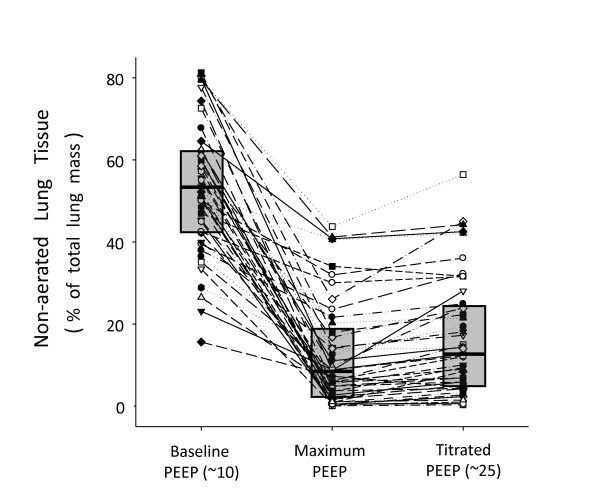
Amount of non-aerated tissue observed along the protocol. Numbers represent the percentage of non-aerated tissue (in relation to the total lung tissue) within the thick lung section (7 to 8 cm thick) from the carina to the diaphragm. Dashed lines represent the 45 individual cases and boxes represent the interquartile range, with a central line representing the median value at each moment.